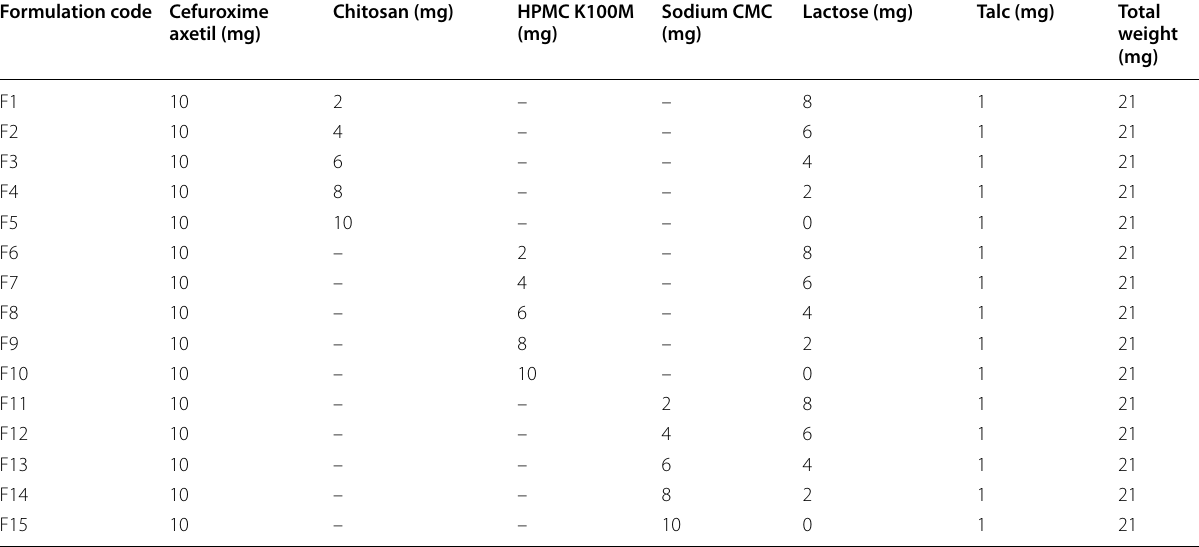
Table 1 Formulation composition of mucoadhesive minitablets of cefuroxime axetil Formulation code Cefuroxime axetil